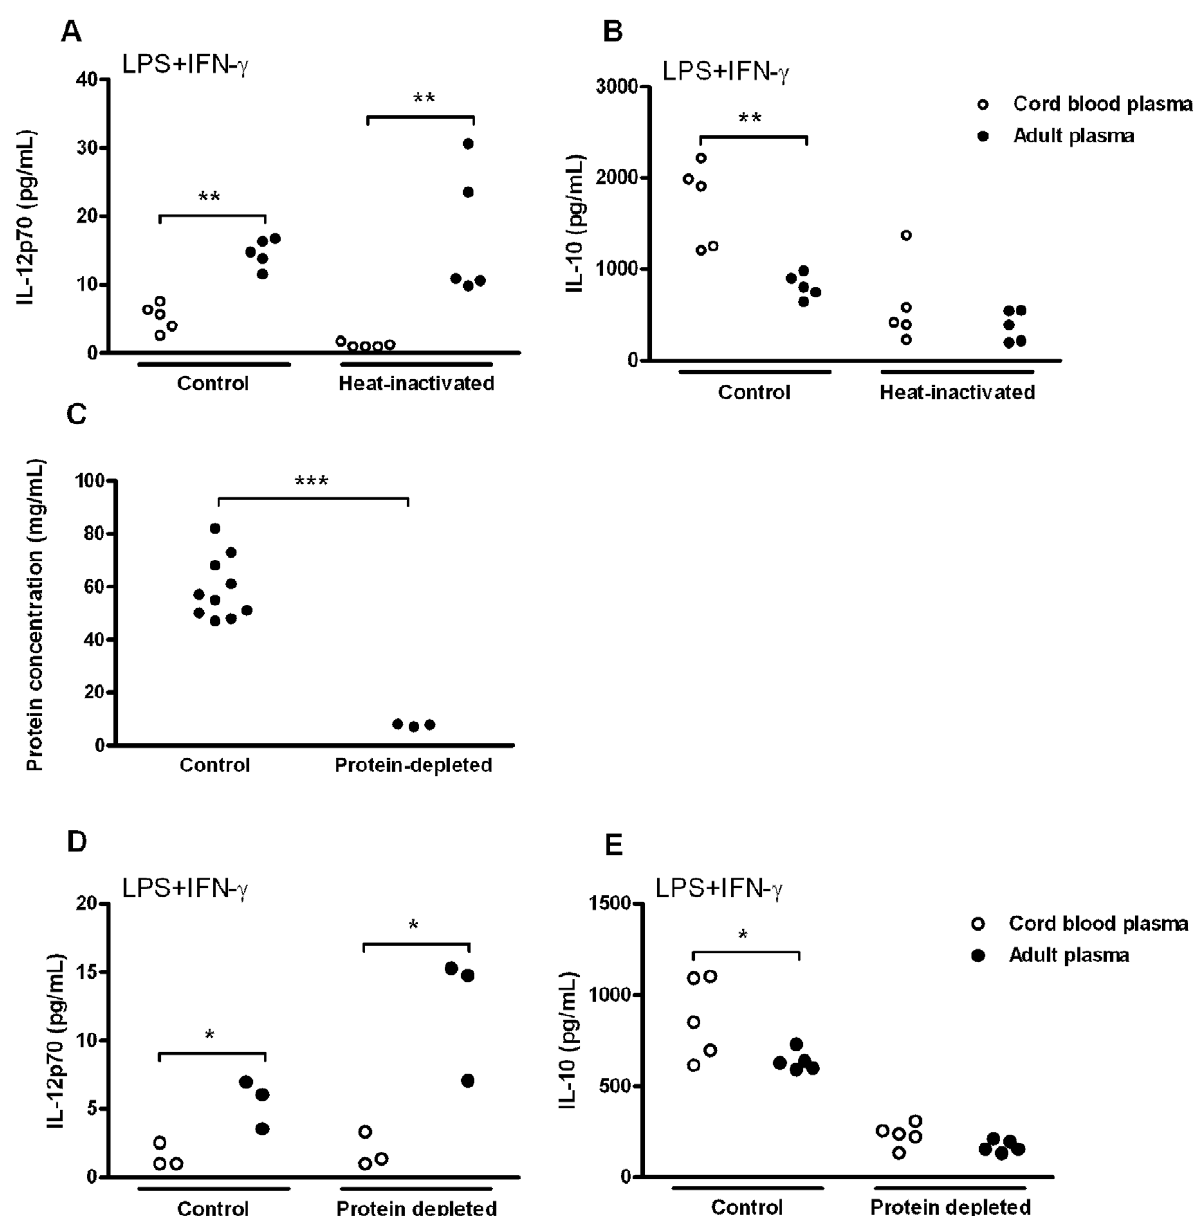
Figure 5. Cord blood plasma modulates TLR4-mediated production of IL-12p70 and IL-10 via distinct factors. A–B; TLR4-mediated production of IL-12p70 (A) and IL-10 (B) by adult PBMC stimulated in the presence of heat-inactivated plasma (30 min at 56 u C) or control plasma. C–E; Effect of protein-depleted plasma on TLR4-mediated cytokine responses. Plasma proteins were depleted by two consecutive cycles of boiling and centrifugation and protein concentrations were measured by BCA protein assay (C). Adult PBMC were stimulated with LPS (100 ng/mL) and IFN- c (20 ng/mL) in the presence of protein-depleted plasma or control plasma, and production of IL-12p70 (D) or IL-10 (E) were measured by ELISA. Each dot represents one individual plasma sample. All data are representative of at least three individual experiments. *; p , 0.05, **; p , 0.01, ***; p ,